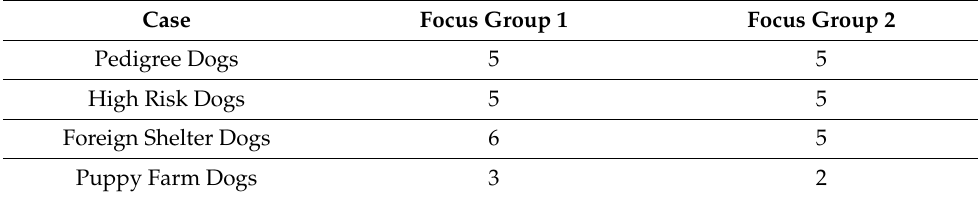
Table 2. Number of participants per focus group of each case. Case Focus Group 1 Focus Group 2 Pedigree Dogs 5 5 High Risk Dogs 5 5 Foreign Shelter Dogs 6 5 Puppy Farm Dogs 3